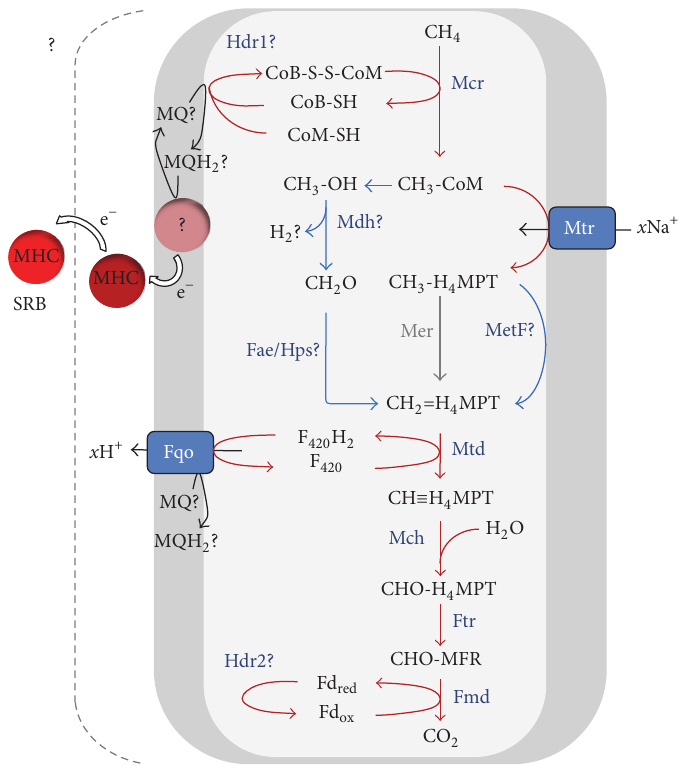
Figure 6: Methanotrophic pathway during S-AOM by ANME-1 [40, 41]. Red lines indicate reversal of the hydrogenotrophic methanogenic pathway, grey lines represent absence of conversions, and blue lines indicate a bypass of the hydrogenotrophic methanogenic pathway. See Table 3 for